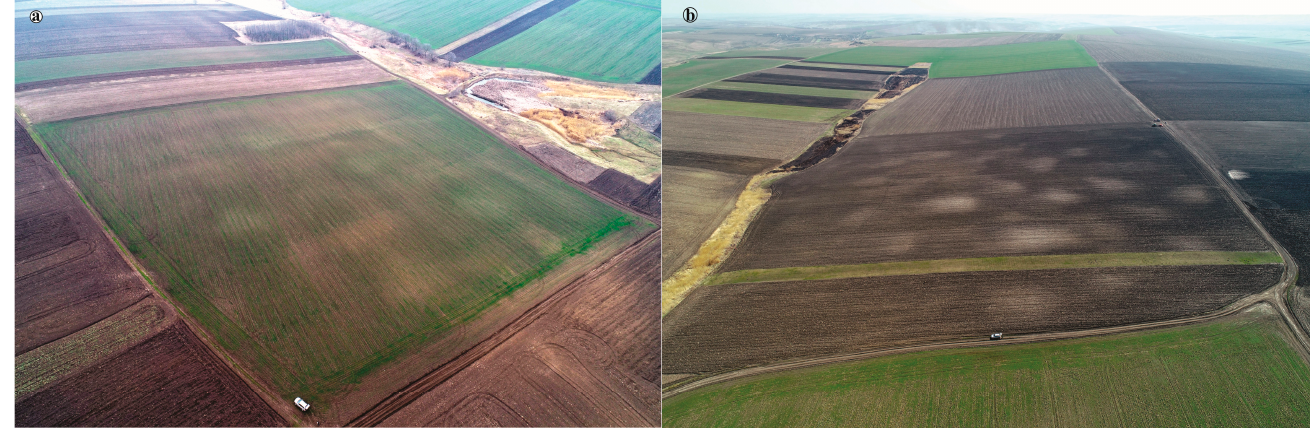
Figure 12. Aerial photographs for the settlements from ( a ) Coarnele Caprei– Aramei Hill I (Ia ș i County), north view; ( b ) B ă deni– Moara de Vânt Hill (Ia ș i County), north view.